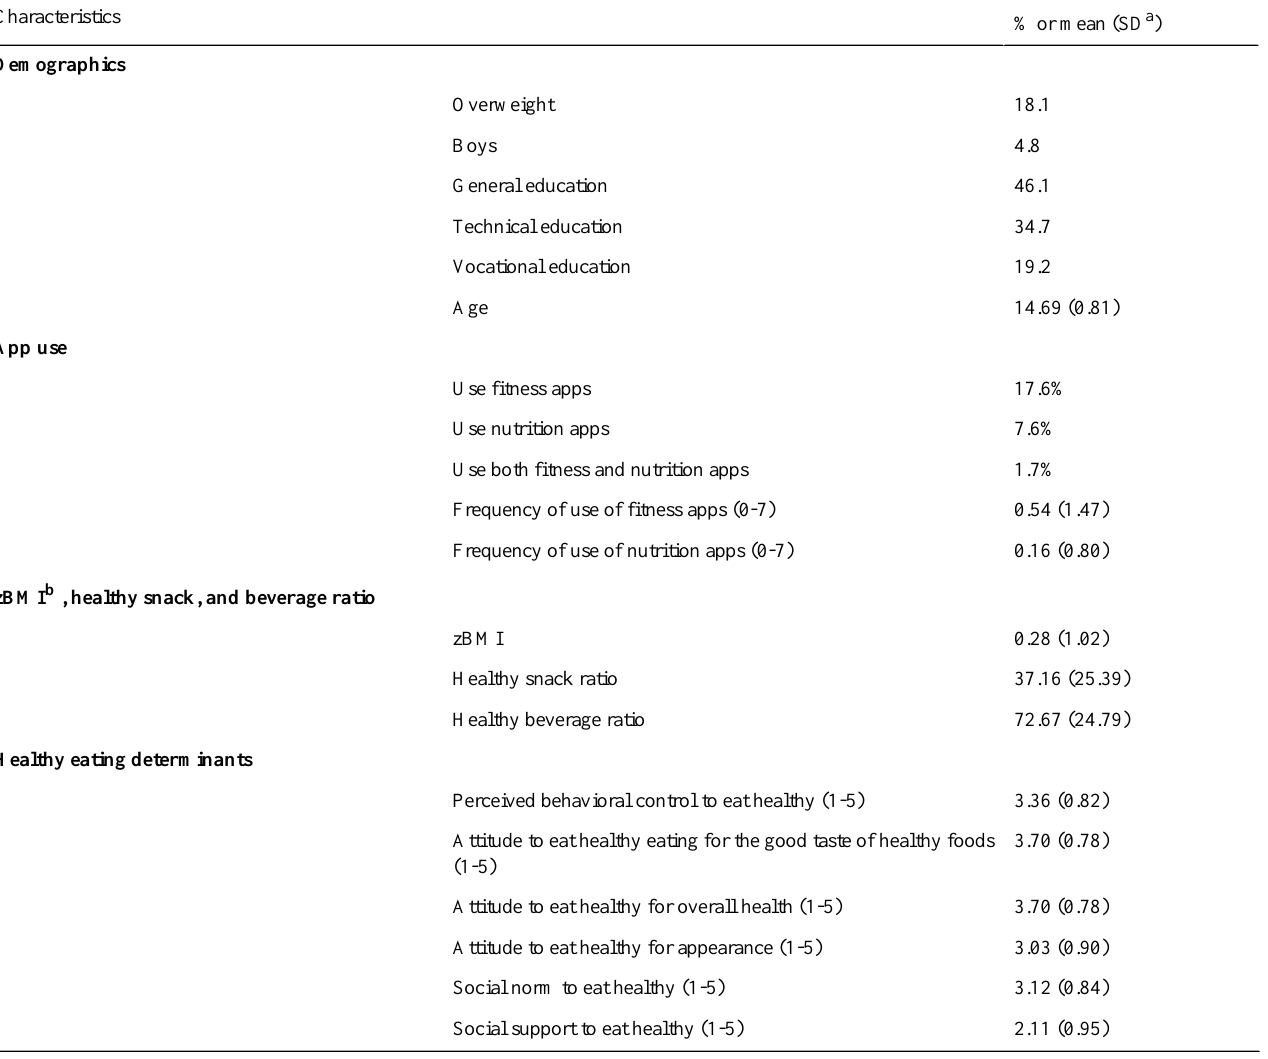
Table 2. Characteristics of the participants (n=889), zBMI, snack and beverage intake, perceived behavioral control, social influences, and